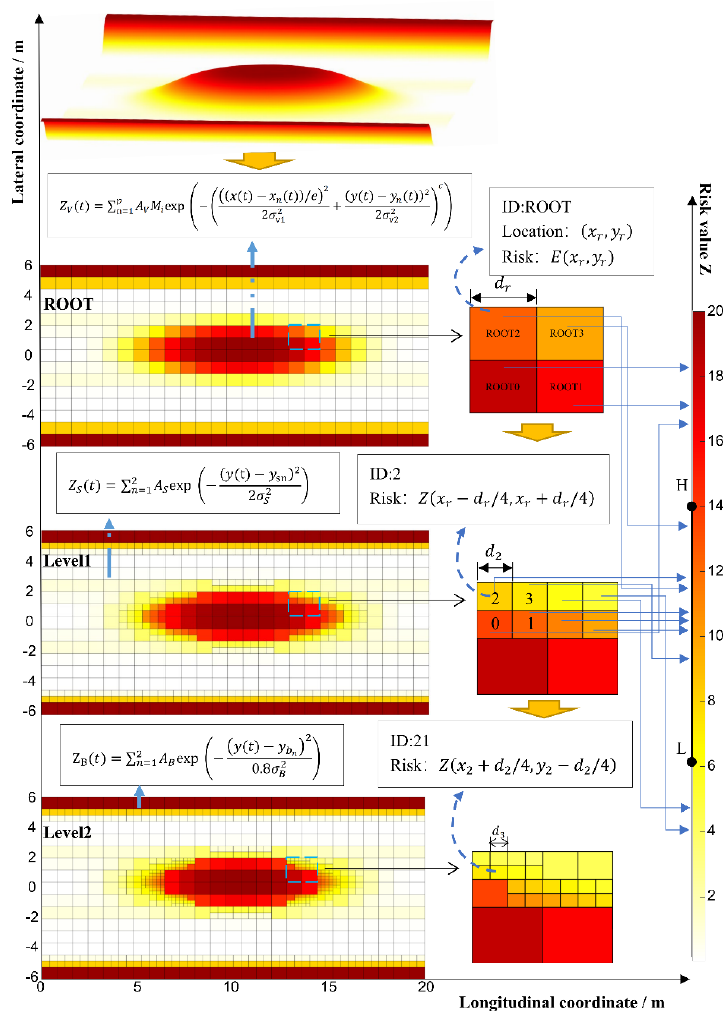
Figure 5. Example of building an adaptive grid risk-field. In the ROOT layer (see Figure 5), the root grid edge length is dr , ROOT0 and ROOT1 are high-risk grids that are not divided, ROOT2 and ROOT3 are medium-risk grids that are divided. In the Level1 layer, ROOT2 is divided into ID0, ID1, ID2, and ID3, and the length of the subgrid of ROOT2 is d 2 = d r /2. ID0 is a non-divided